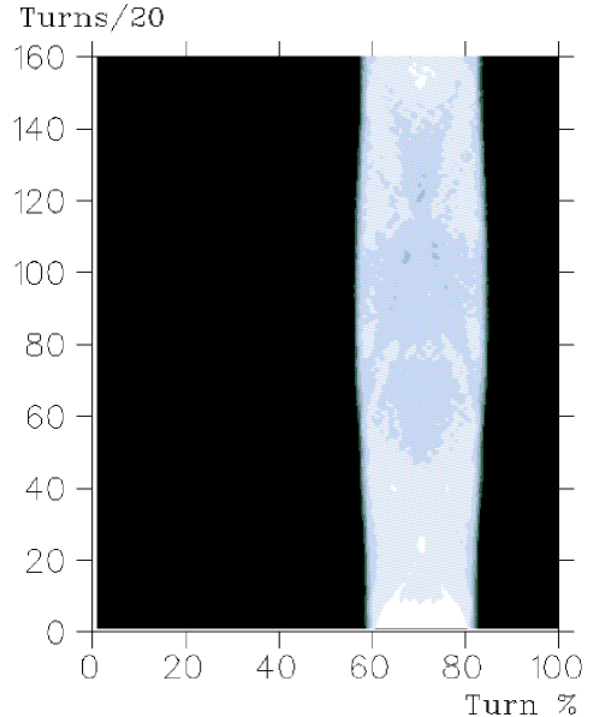
FIG. 22. Waterfall plot of line density for single matched hole (but offset in azimuth) for 3200 turns. Beam current set to give stationary hole. 5 3 10 12 protons, 2.4 3 10 5 macroparticles.